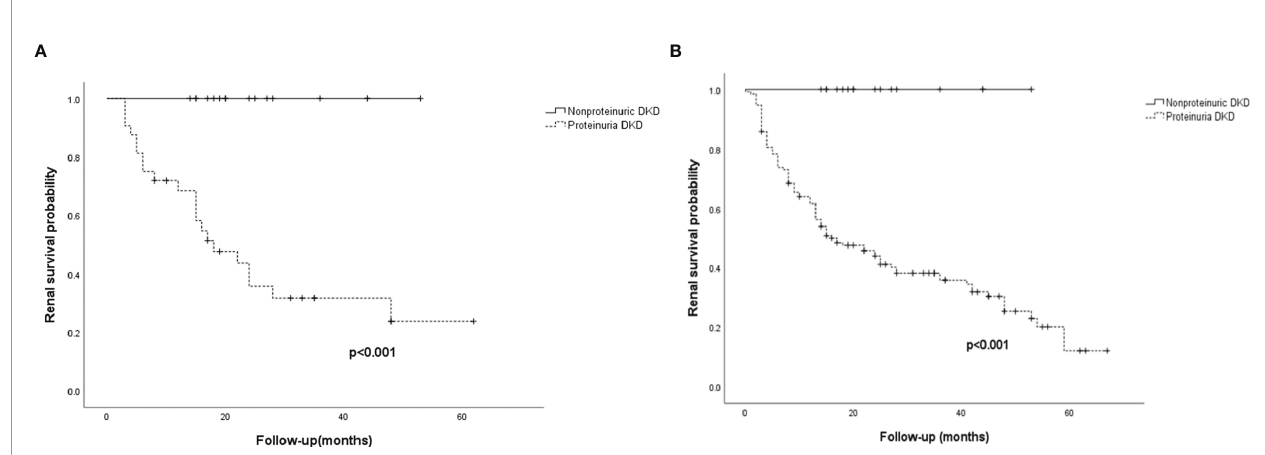
FIGURE 2 | Renal survival for the 54 patients in the propensity score-matched cohort and the 168 patients in the overall cohort. (A) Kaplan-Meier curves of renal survival in the propensity score-matched cohort. (B) Kaplan-Meier curves of renal survival in the overall cohort. ESRD was de fi ned as initiation of hemodialysis/ peritoneal dialysis, renal transplantation, or death as a result of uremia. Nonproteinuric DN was de fi ned as patients with an eGFR<60 mL/min/1.73 m 2 without proteinuria (UACR<300 mg/g); proteinuria DN was de fi ned as patients with an eGFR<60 mL/min/1.73 m 2 and proteinuria (UACR>300 mg/g).